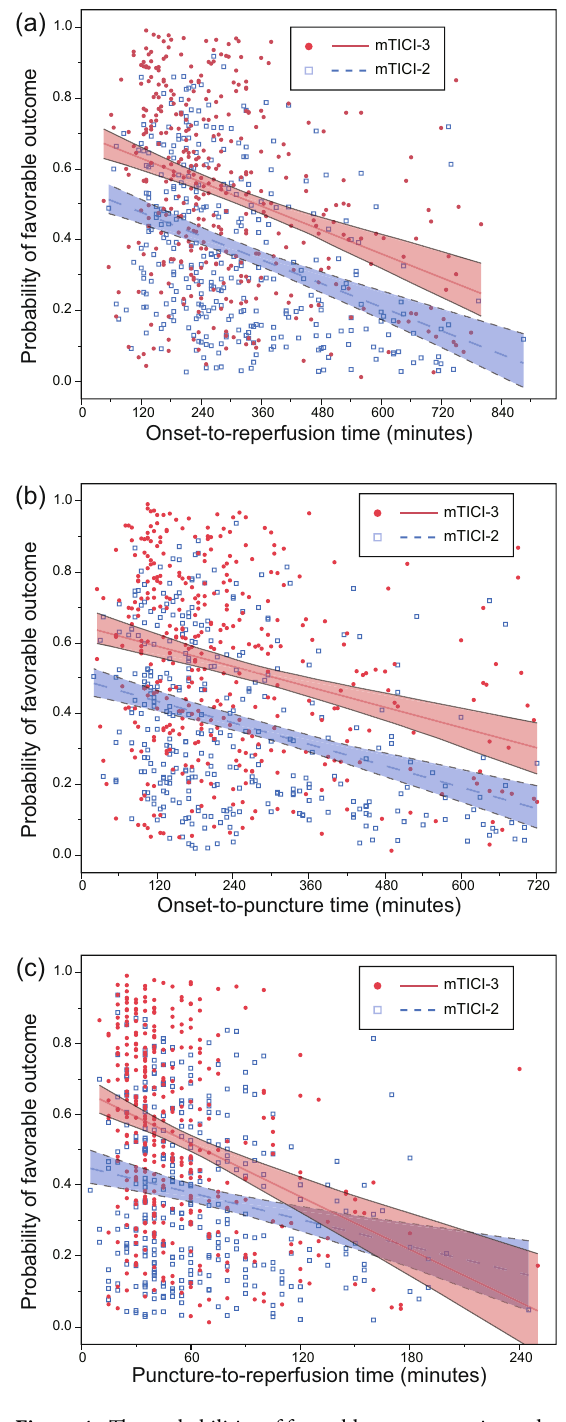
Figure 4. The probabilities of favorable outcome estimated using logistic regression with stratification by mTICI scores are plotted. The regression lines and 95% confidence intervals are shown. The time course was included as a continuous variable. ( a ) On onset-to-reperfusion time. Adjusted for baseline characteristics (age, sex, National Institutes of Health Stroke Scale score, Alberta Stroke Program Early Computerized Tomography Score, target occlusion location, intravenous alteplase). ( b ) On onset-to-puncture time. Adjusted for baseline characteristics and puncture-to-reperfusion time. ( c ) On puncture-to-reperfusion time. Adjusted for baseline characteristics and onset-to-puncture